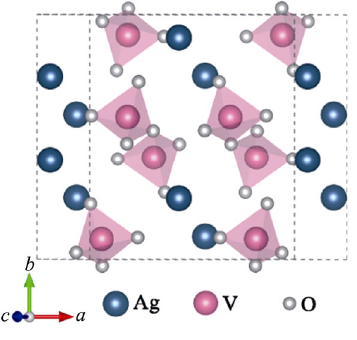
Fig. 4 Crystal structure of α -AgVO 3 .